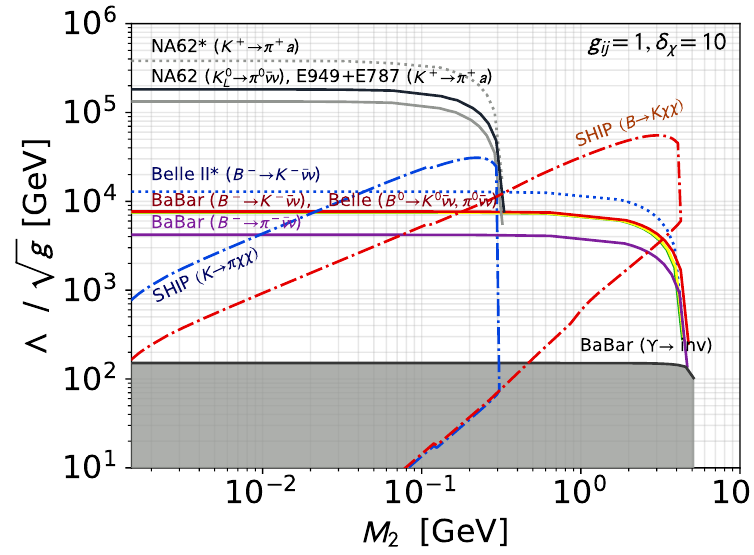
p g for the vector-current